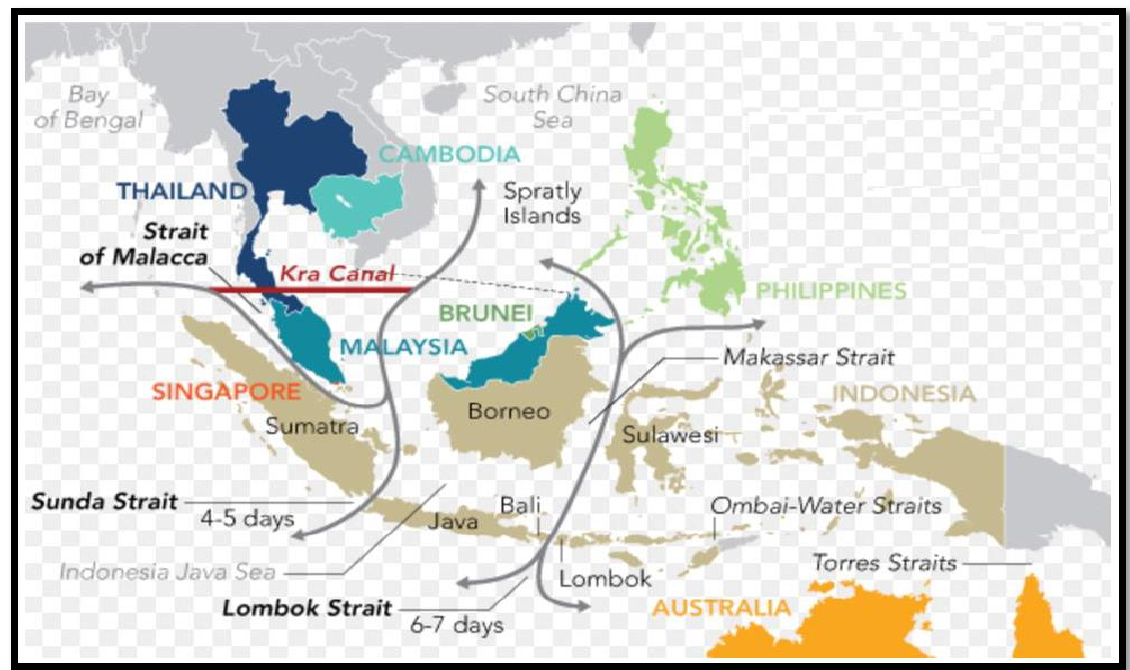
Figure 2: Kra canal in Malaysian trade